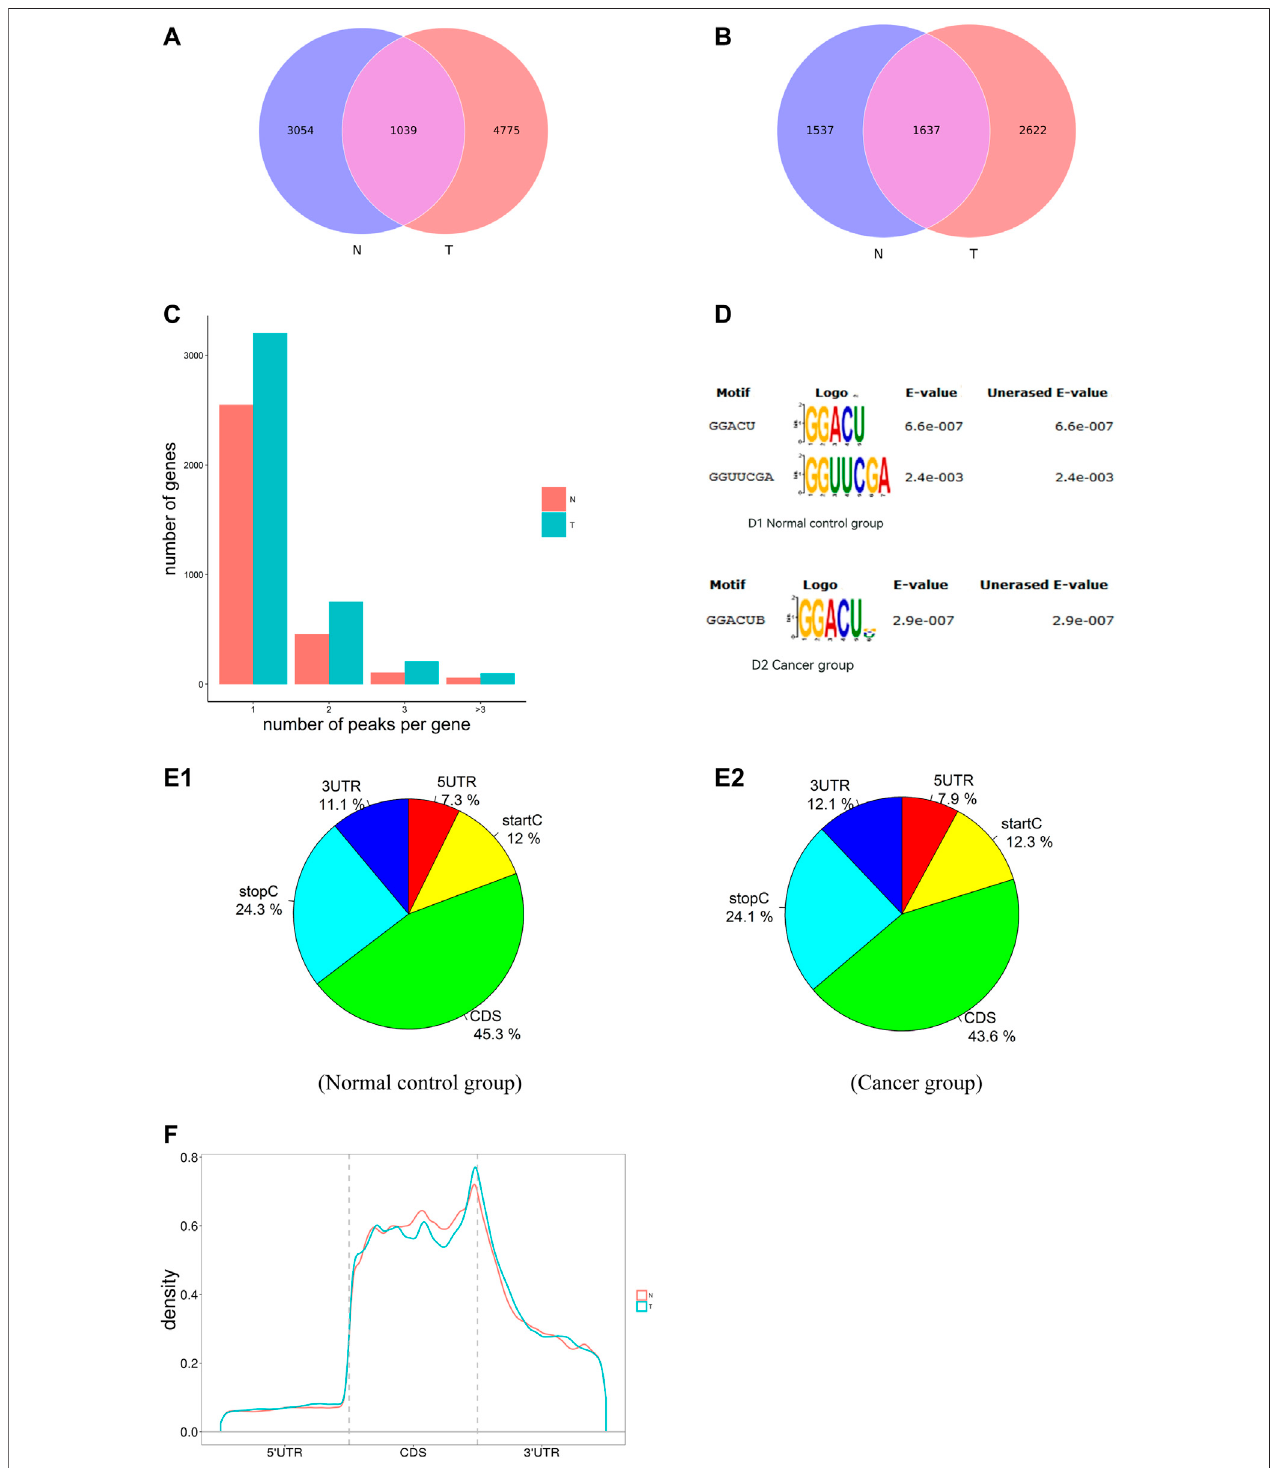
FIGURE1 | Characteristics ofm 6 A methylation in AEG. (A) The conserved/speci fi c m 6 A methylation peak. (B) The conserved/speci fi cm 6 Amethylation genes. (C) the distribution of m 6 A-modi fi ed peaks per gene. (D) The RRACH conserved sequence motif for m 6 A-containing peak regions. (E) The percentage of m 6 A methylated peaks in transcripts. Each transcript is divided into fi ve parts: 5 ′ UTRs, CDS, 3 ′ UTRs, start codon, stop codon. (F) Accumulation of m 6 A peaks along with transcripts. m 6 A, N 6 -methyladenosine.